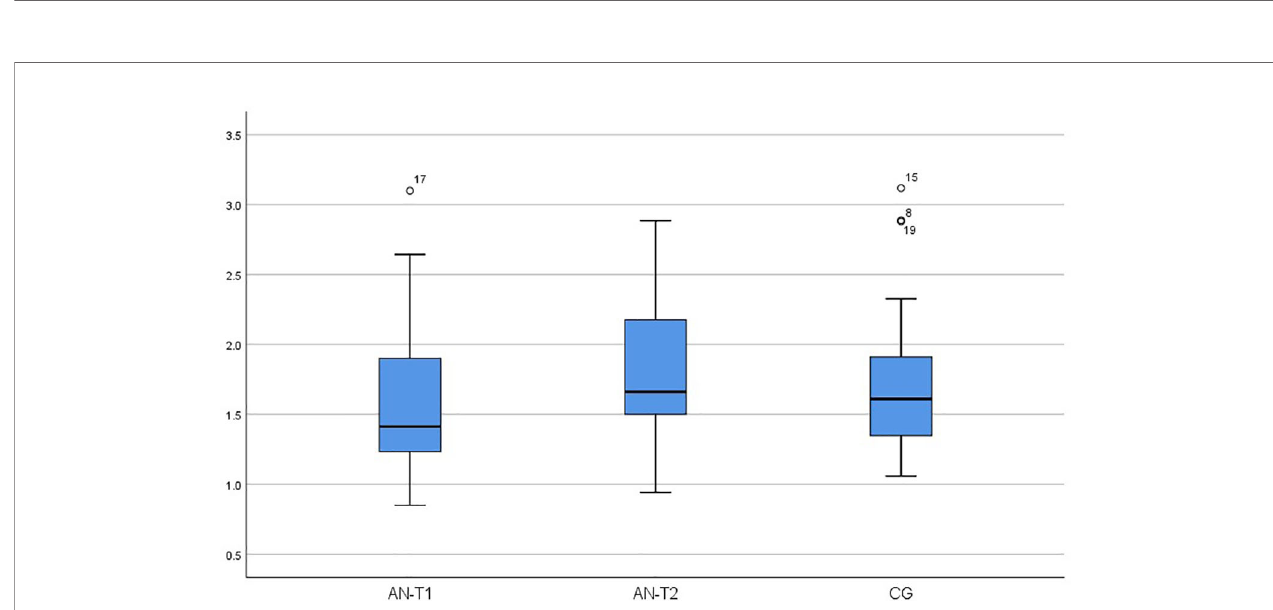
FIGURE 3 | Serum tropomyosin-related kinase B receptor (TrkB) concentration in adolescent anorexic inpatients in the acute stage of the disease (AN-T1) as well as after partial weight normalization (AN-T2), and in the control group (CG).